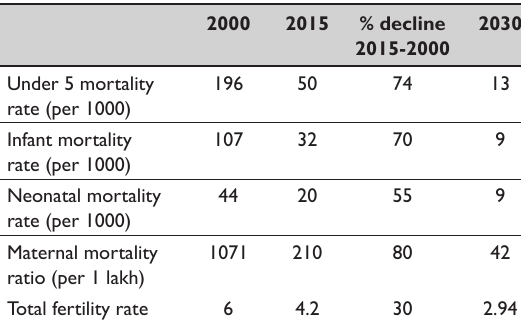
Table 3: Projected decline in key